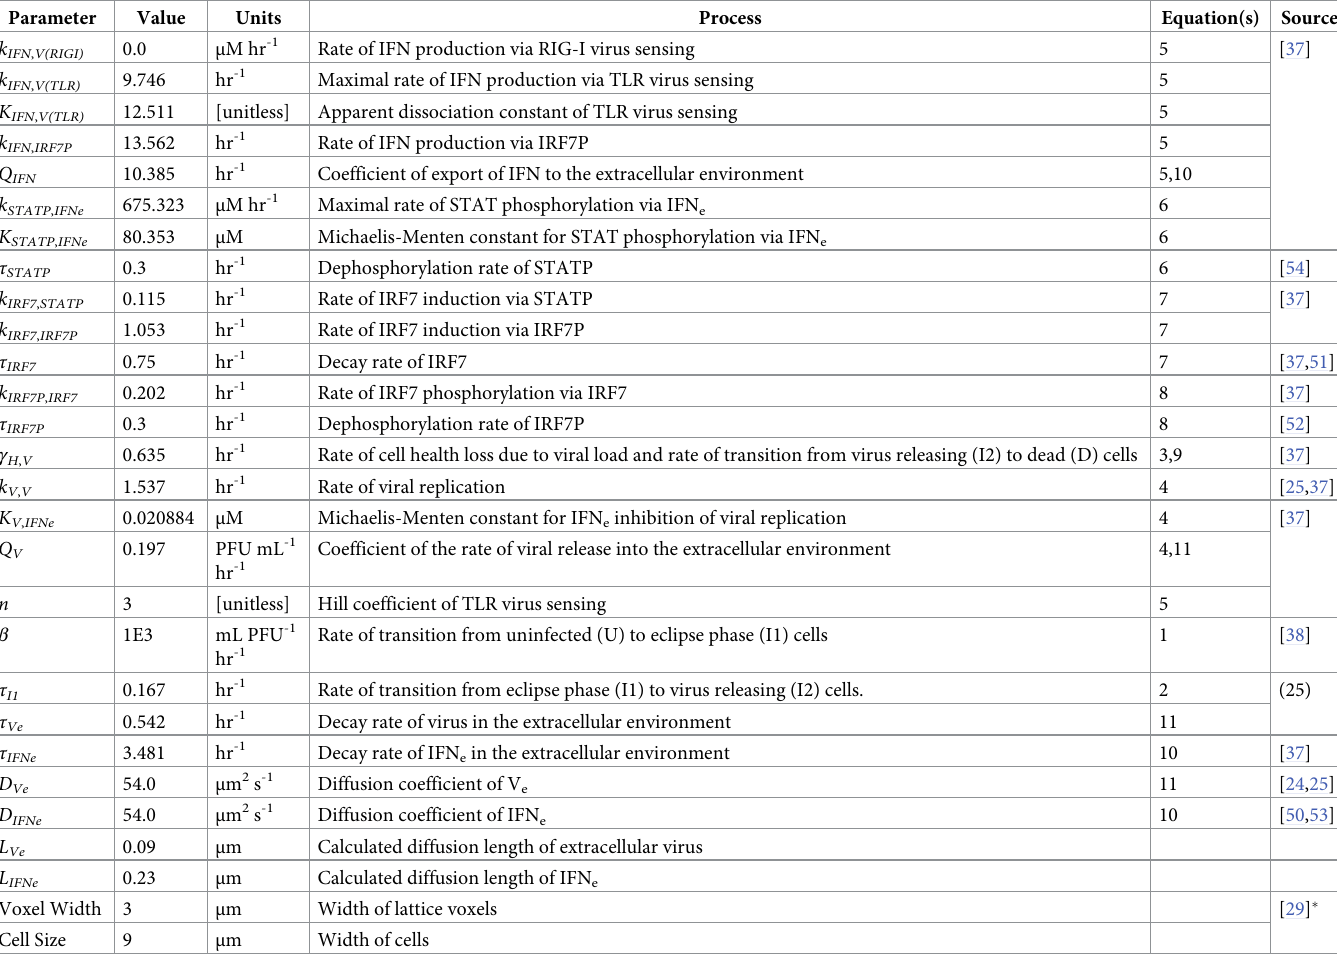
Table 2. Baseline parameter values and sources. Parameters marked with � are specific to the CompuCell3D’s implementation of the